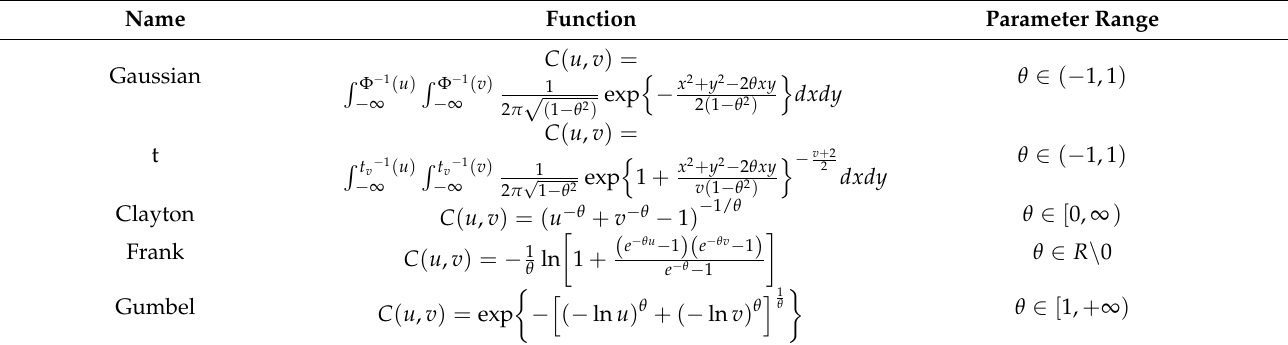
Table 3. Summary of five commonly used bivariate